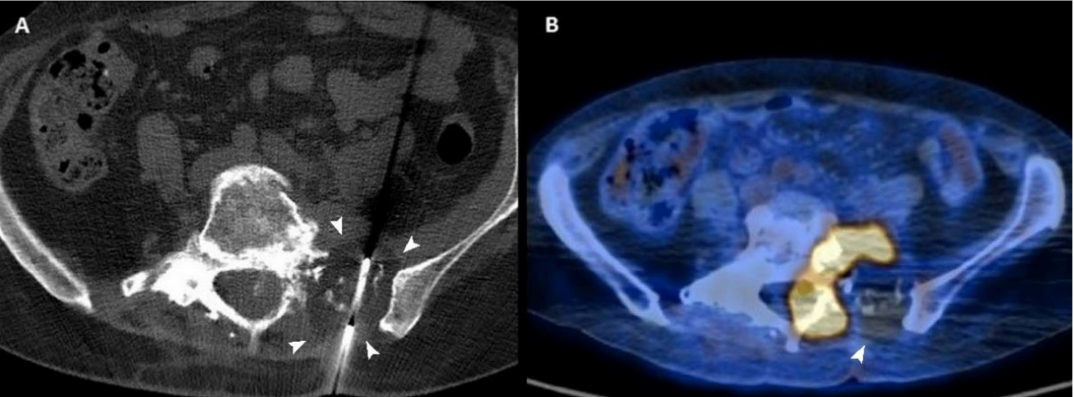
Figure 3. ( A ) Axial CT scan of a 54-year-old woman with a sacral metastasis from endometrial sarcoma treated with cryoablation for palliative intent. The ice ball is visible as a hypodense circle surrounding the tip of the needle (arrowheads). ( B ) 18F-FDG PET/CT scan performed 3 months after the procedure demonstrates the absence of pathologic radiotracer uptake in the ablated area